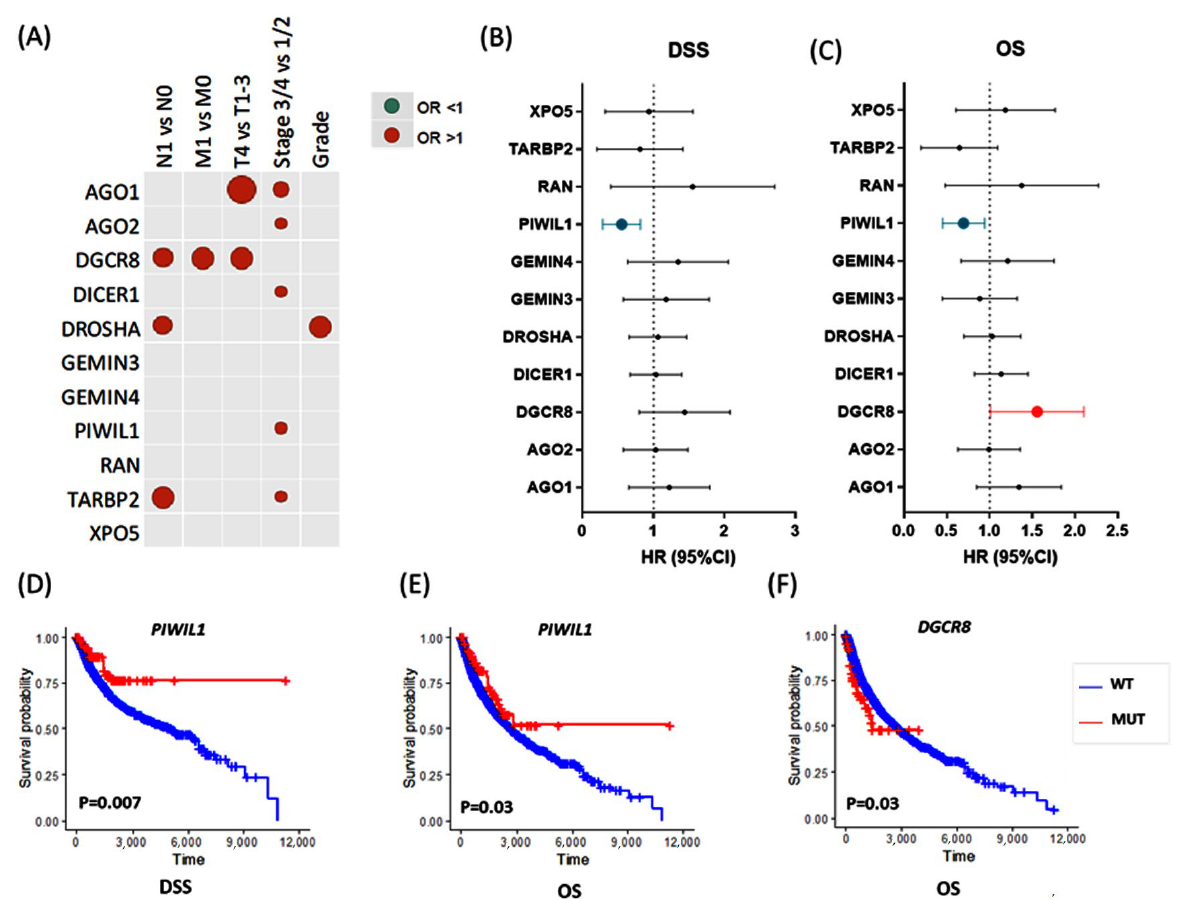
Figure 7. The 11 miRNA machinery gene mutations are potential prognosis markers in a pan-cancer study. Comparisons for mutant versus wild type were performed. ( A ) Dot plots show the association between the gene mutants and advanced pathological characteristics. The higher odds ratio of univariate regression analysis imposed by each gene mutation on various pathological parameters of overall pan-cancer samples. The size of the dots is equivalent to the p -values. Only significant associations are shown. N: lymph node stage, M: metastasis stage, T: tumor size stage. ( B , C ) Association of gene mutations with disease-specific survival (DSS) and overall survival (OS). Data of multivariate Cox regression models are presented as hazard ratio (HR) and 95%